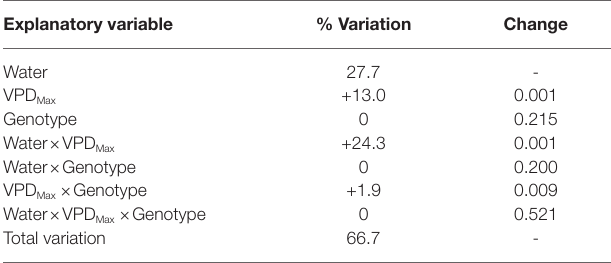
TABLE 4 | Two-sample t -test results for daily water use of cotton with differing transpiration response at each VPD environment. TR Linear water Daily VPD use environment